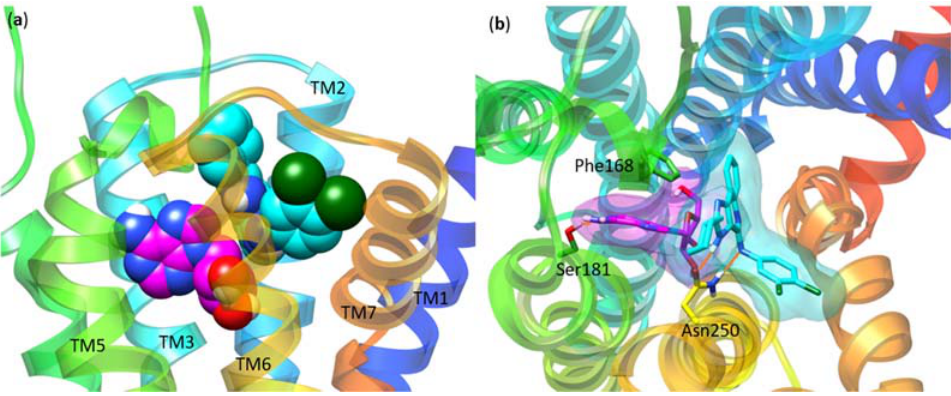
Figure 8. Representation of the ternary complex between hA 3 AR, the endogenous agonist adenosine ( 1 , magenta) and the positive allosteric modulator LUF6000 ( 25 , cyan) as obtained by supervised molecular dynamics (MD) simulation [20]: side view ( a ) and top view ( b ). The residue Ballesteros– Weinstein notation [32] is: Phe168 (EL2), Asn250 (6.55), and Ser181 (5.42).